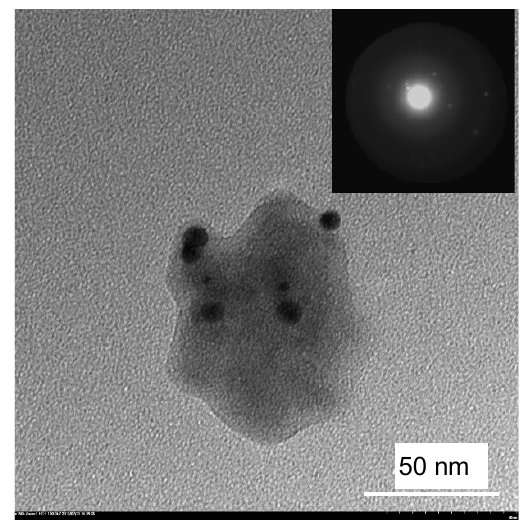
Figure 4. TEM image of the calcined SilAg sample. Table 1. The diffraction peaks (2 θ , degrees) detected in sample the SilAg (calcined).